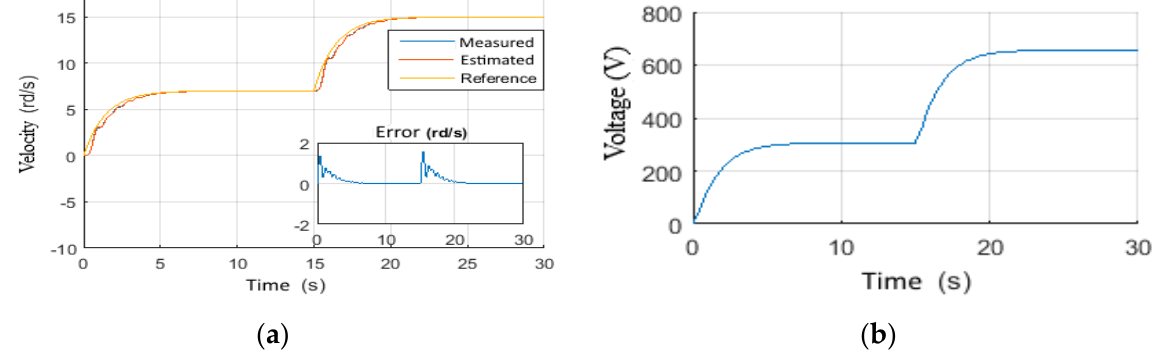
Figure 26. Observer-based controller responses: ( a ) Controlled drill bit velocity, ( b ) Control volt-